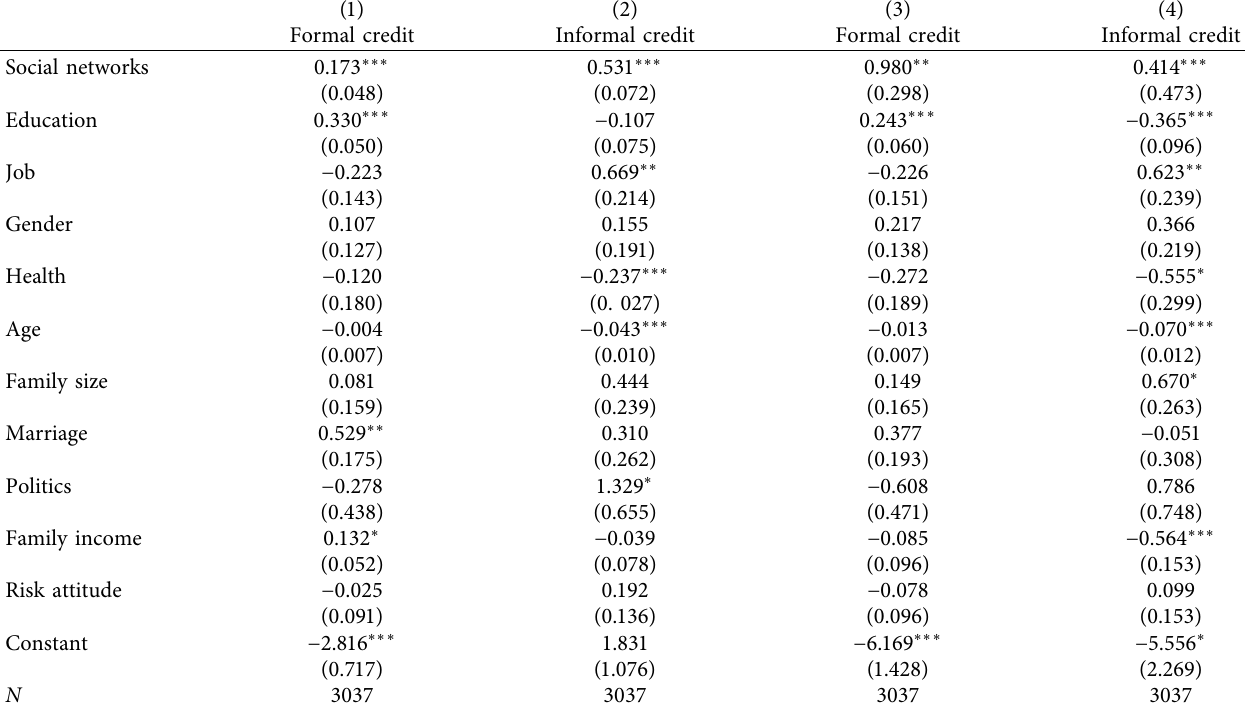
Table 4: Impact of social networks on formal and informal credit